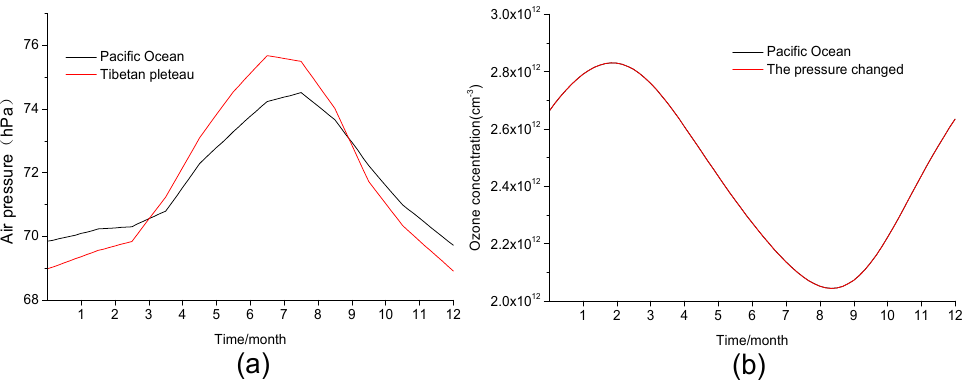
Figure 4. The results of air pressure changes, ( a ) time-dependent variations in air pressure in the two